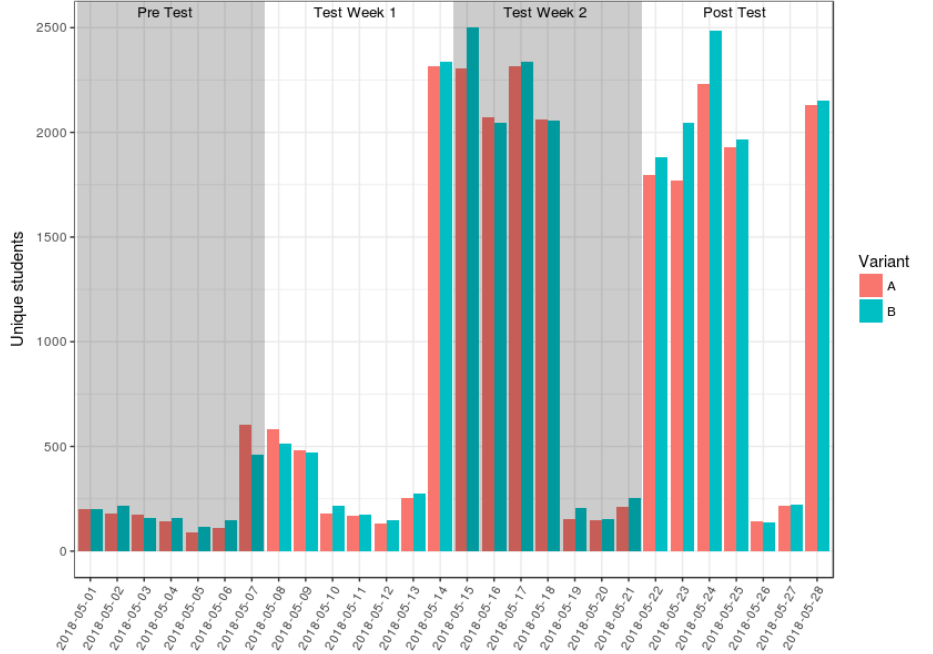
Figure 2. Daily number of responses in the Math Garden for the two testing variants A (control) and B (experiment). Several national holidays reduced the number of responses on these